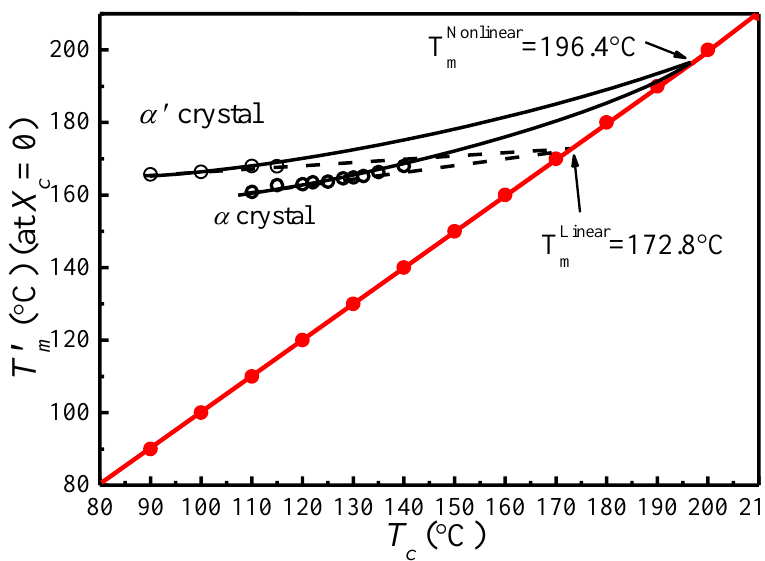
Figure 7. Observed melting temperature of initial lamellar crystals as a function of the crystallization temperature. The solid curve is the nonlinear MH extrapolation (Marand Herve method) calculated using a = 7.85, γ = 1, and 𝑇 m0 = 196.4 °C for α crystal; and a = 10.83, γ = 1, and 𝑇 m0 = 196.4 °C for α ′ crystal. The dotted curve is the linear HW extrapolation (Hoffman–Weeks method) based on experimental data points.